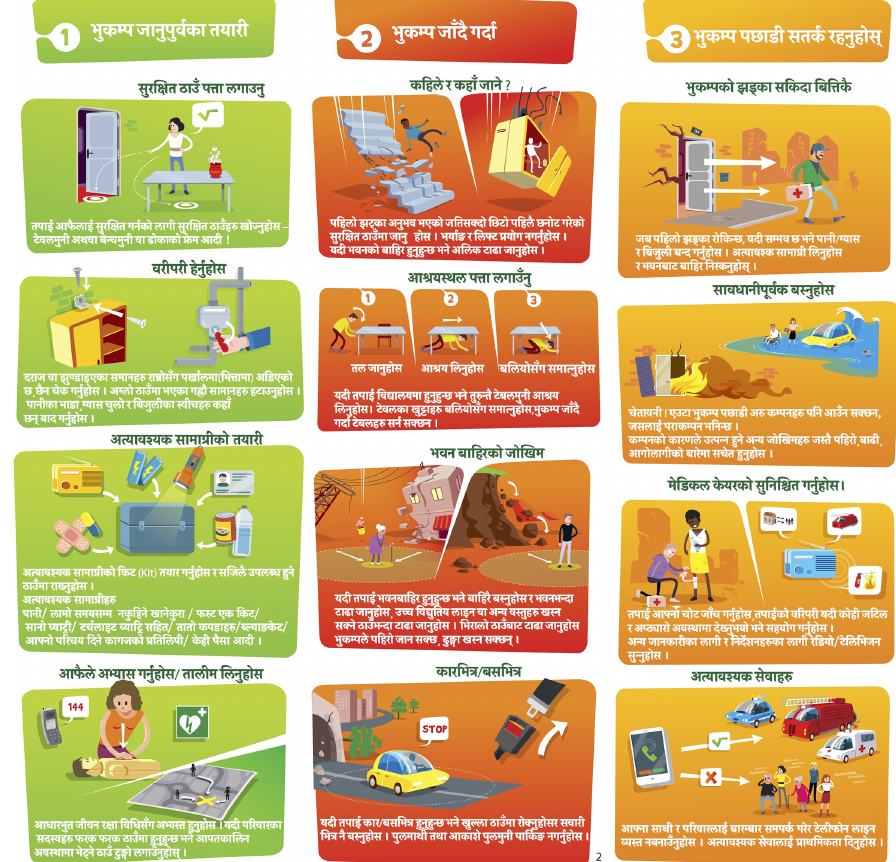
Figure 4. Educational flyer in the Nepali language on what to do before, during and after an earthquake. The flyer has been translated and adapted from an English version compiled by and available from the Centre for Earthquake Prevention (CPPS) earthquake education center in Sion, Switzerland (http://www.cpps-vs.ch, last access: 18 September 2020). The Nepali flyer is available for download from our program’s web page at http://www.seismoschoolnp.org.